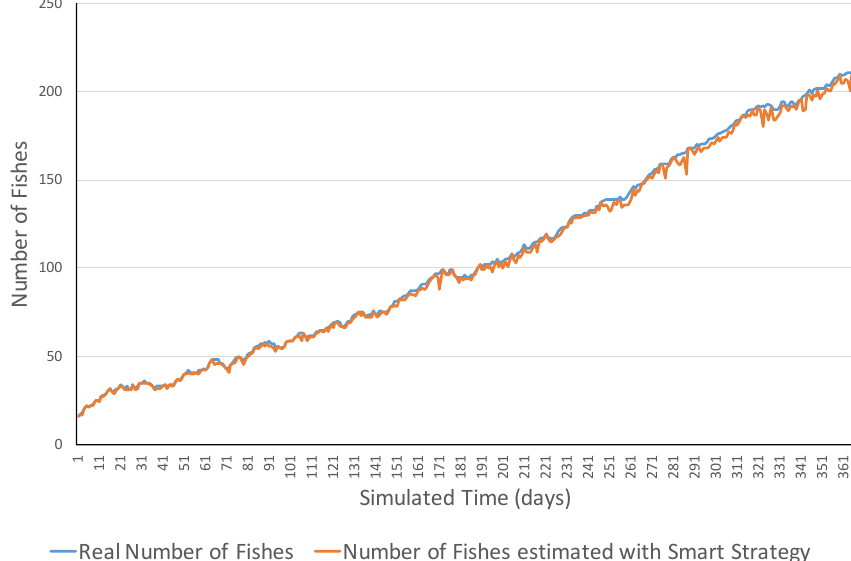
Figure 5. Simulation evolution of an increasing ecosystem with the smart strategy.